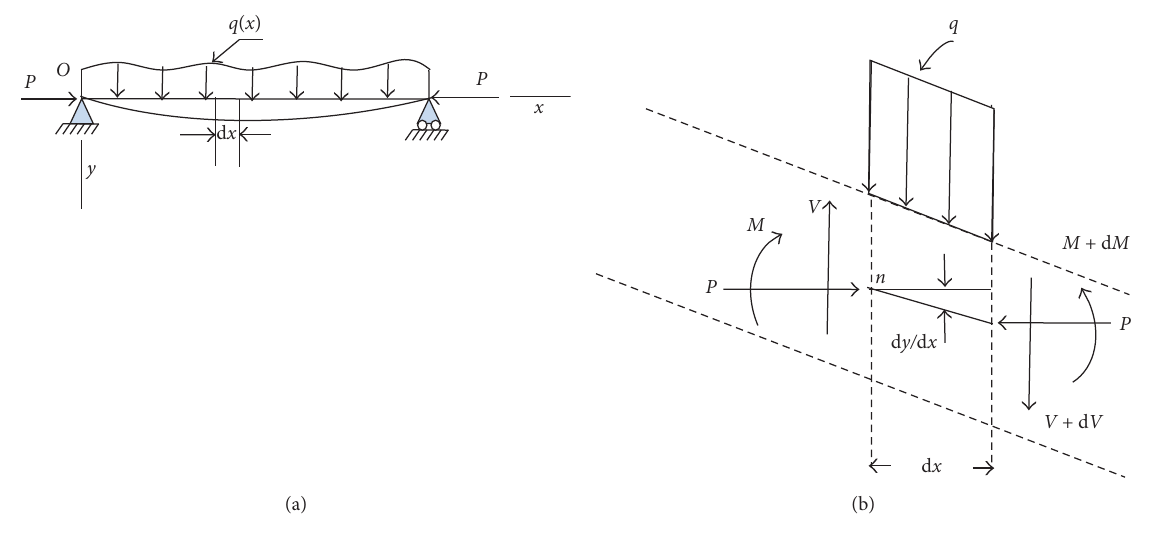
Figure 1: Cross-sectional presentation of the beam-column design. Table 1: Comparison of approximate solutions obtained by LeNN-NM algorithm with the exact solution and RK-5 method [27] along with absolute errors for Problem 1.